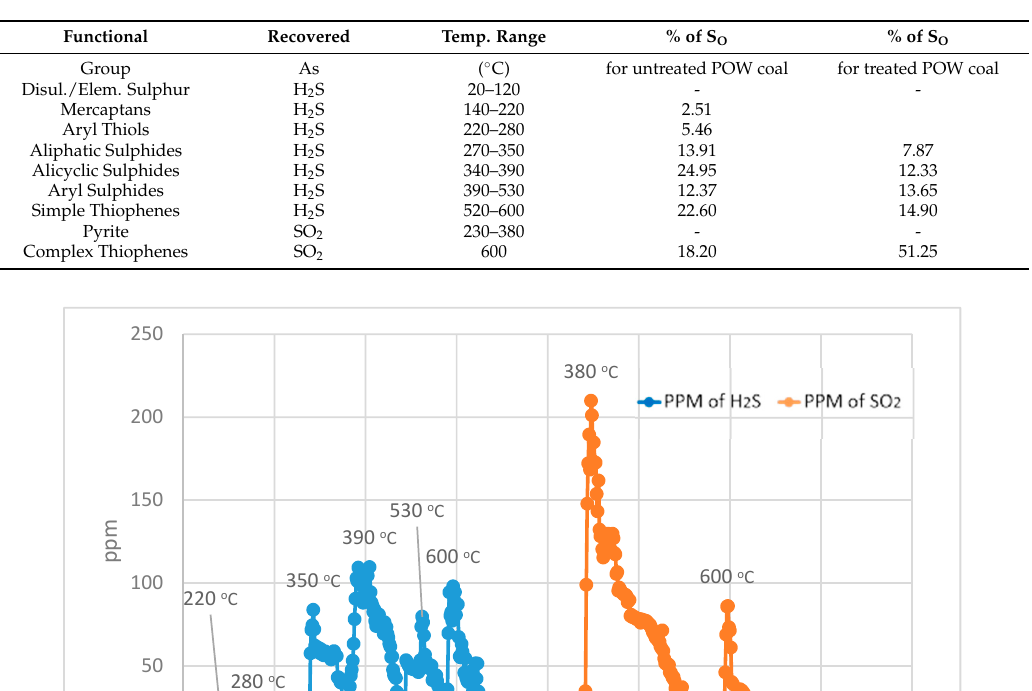
Table 10. Results for the TPI of untreated prince of wales.